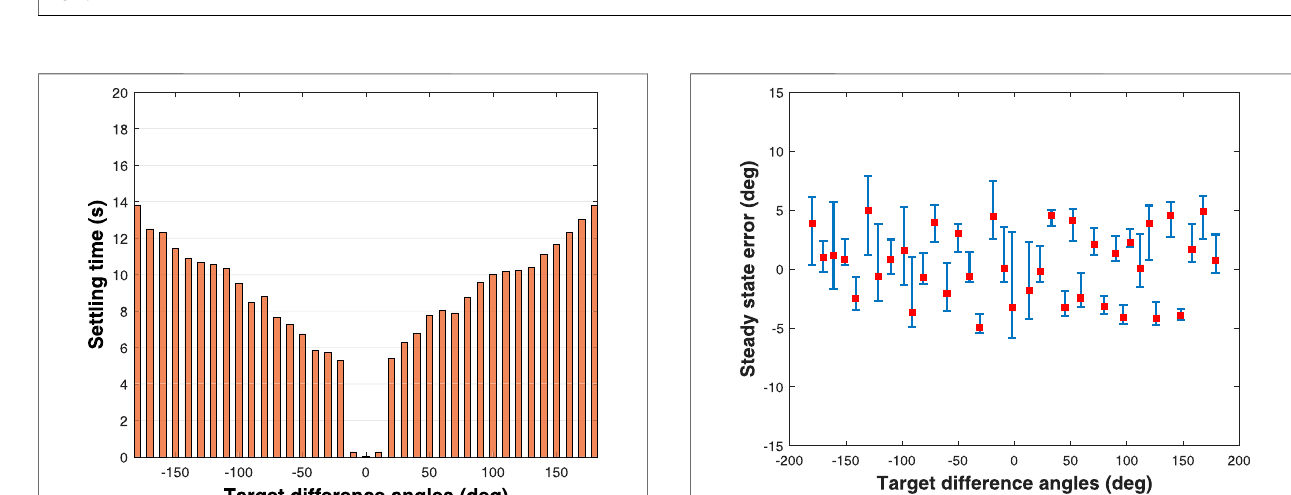
; (D) the yaw angle of the 2